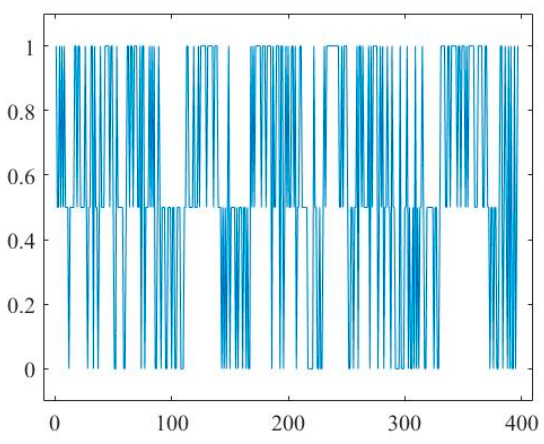
Figure 3. An example of a digital representation of Tahafut al-Falasifa chunks.